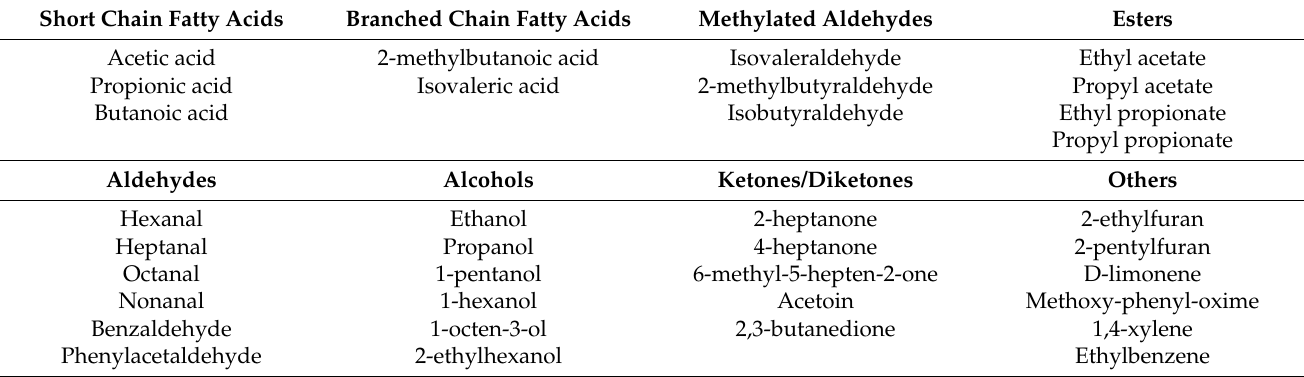
Table 2. Summary of 36 volatile organic compounds (VOCs) found in at least 25% of